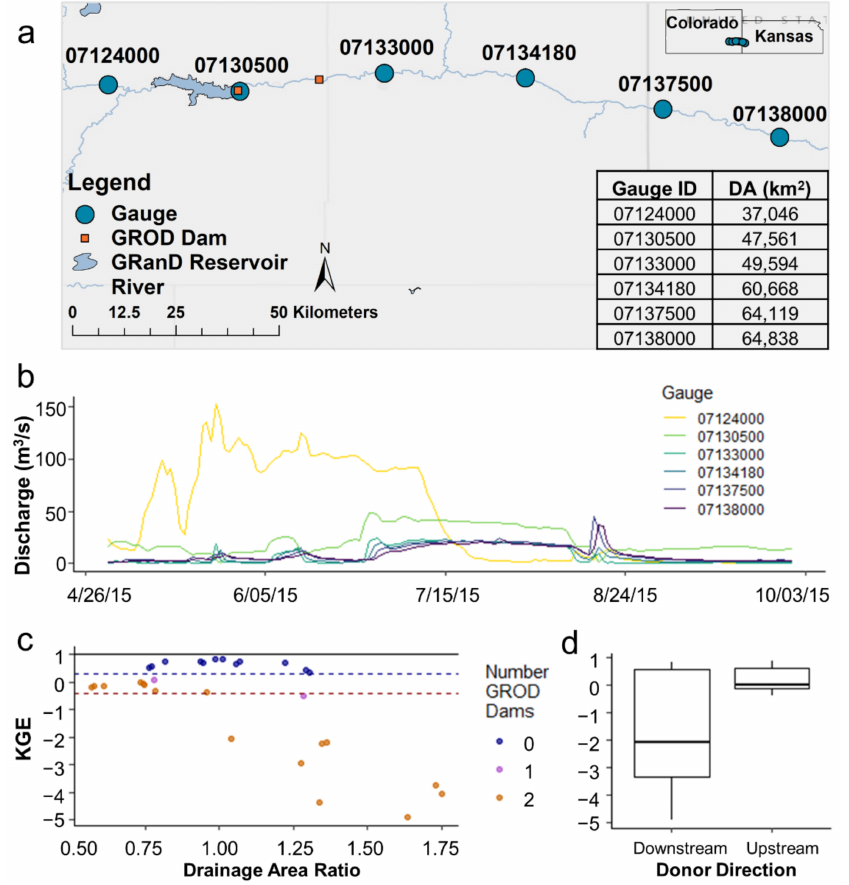
Figure 6. Case study of the effect of reservoirs and dams on discharge and Kling Gupta Efficiency (KGE) values. ( a ) Six gauges near the John Martin Reservoir spanning parts of Colorado and Kansas. Gauge ID’s and drainage area are recorded, and drainage area ratios between the gauges span from 0.57 to 1.75. ( b ) Example of daily discharge time series from May to September 2015 for each gauge record. ( c ) KGE vs. drainage area ratio for all gauge interactions colored by the number of GROD Dams between compared gauges. The black horizontal line at 1 indicates the optimal KGE value, the blue dashed line indicates the study’s defined “good” KGE value of 0.32, and the red dashed line is at KGE = − 0.41, the threshold for the metric where the model improves upon the mean flow benchmark ( d ) Boxplots of the KGE metrics according to the direction of donation from the donor